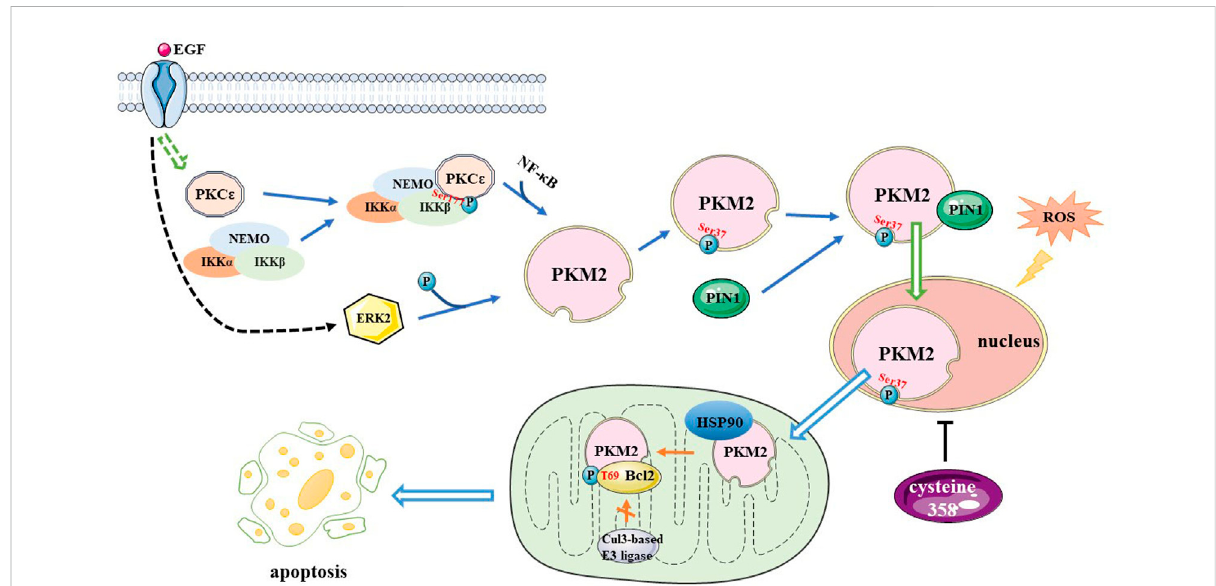
FIGURE 3 A mechanism for PKM2 regulation. EGF induces PKC ε generated to phosphorylate IKK β at Ser177, increasing PKM2 expression, and NF- κ B is involved in this process. EGF also activates ERK2, which phosphorylates PKM2 at the Ser37 site, allowing PIN1 to bind to it, it also promotes PKM2translateto nucleus. OxidativestressinducesPKM2translocation to mitochondria andphosphorylatesBcl2atT69sitewiththehelpofHsp90, preventing the Cul3-based E3 ligase from binding to Bcl2 and increasing the resistance of glioma cells to oxidative stress-induced apoptosis. Cysteine 358 oxidation inhibits PKM2 activity, activating the reactive oxygen species scavenging system. PKM2, pyruvate kinase M2; EGF, Epidermal growth factor; PKC, protein kinase C; IKK, I κ B kinase; NF- κ B, nuclear factor kappa enhancer binding protein; ERK, extracellular signal-regulated kinase; Bcl2, B-cell lymphoma 2; T, threonine; HSP90, Heat Shock Protein 90; Cul3, cullin